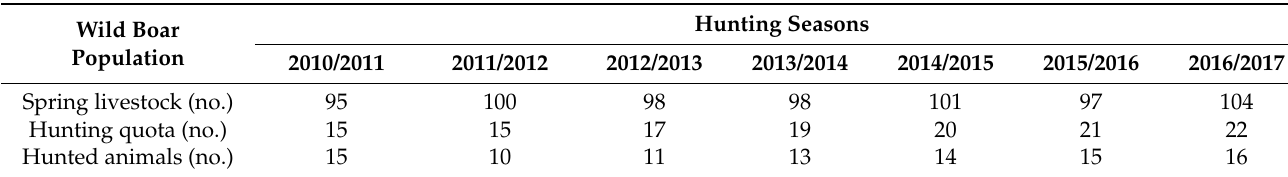
Table 1. Wild boar population dynamics in the Frasin Forest